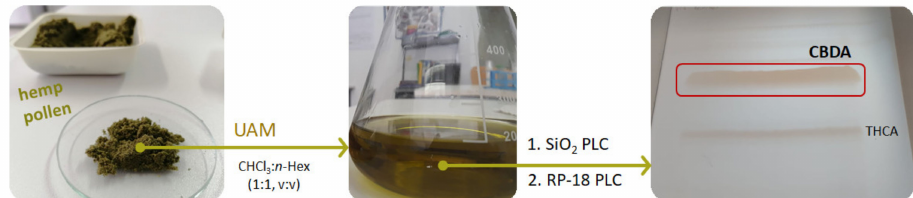
Figure 4. Hemp pollen underwent ultrasound accelerated maceration (UAM), and an aliquot of hemp pollen (HP) extract (60 mg) was then chromatographed by preparative thin-layer chromatography (PLC) using a precoated silica gel 60 F254 (20 × 20 cm, 1 mm, Merck, Darmstadt, Germany). The organic lower phase of a biphasic CHCl 3 / MeOH / H 2 O (13:7:7, v / v / v ) solution served as mobile phase. Among the five fractions obtained, one was further fractionated by thin-layer chromatography using a precoated silica gel 60 RP-18 F254S (20 × 20 cm, Merck, Darmstadt, Germany). Elution was twice by MeCN / H 2 O (4:1, v / v ) solution. The main compound (yield 45%) was identified, by means of spectroscopic